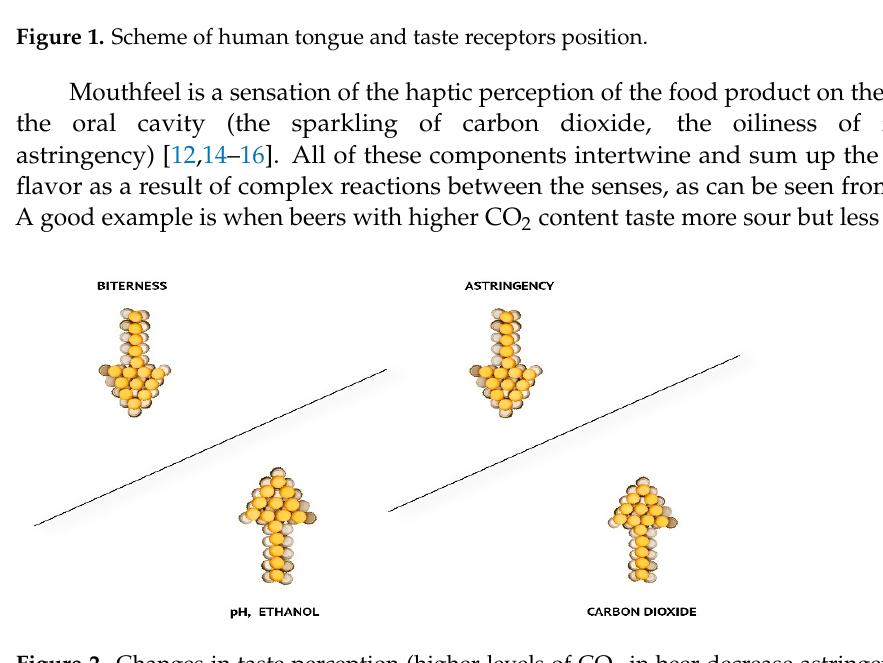
Figure 2. Changes in taste perception (higher levels of CO 2 in beer decrease astringency; higher C 2 H 5 OH concentration and higher beer pH increase the bitterness perception) [12].